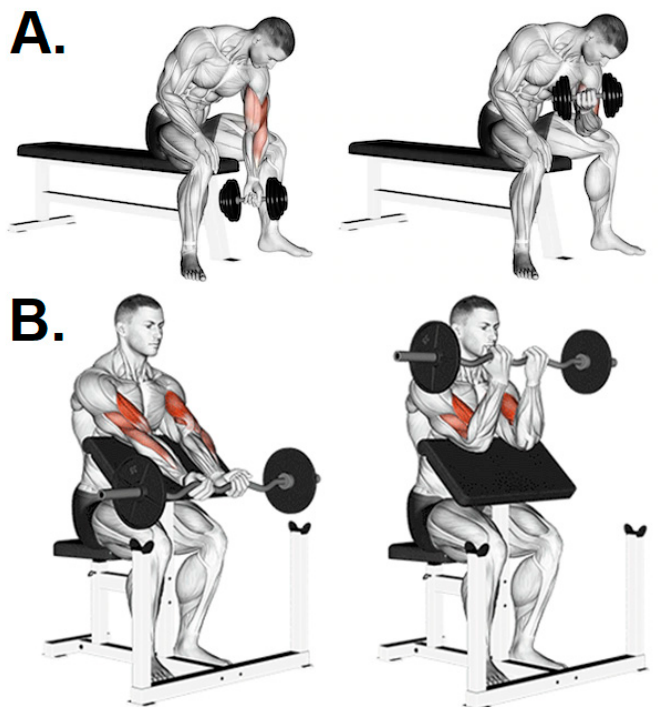
Figure 3. Seated bicep curls: ( A ) one-arm dumbbell concentration curl increases thoracic–lumbar kyphosis; ( B ) EZ bar Scott (preacher) curl provides proper positioning of the cervical and thoracic vertebrae. Source: Taken from Gym Visual available at https://gymvisual.com/ under copyright and owned by Aliaksandr Makatserchyk. Accessed on 14 January 2022.